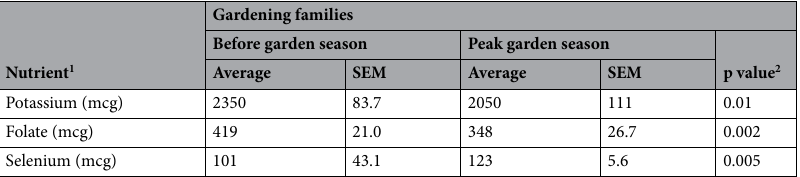
Table 4. Diet record nutrient differences within gardening families from before the garden season to peak garden season. 1 Average nutrient values ± SEM. 2 Two-sided Wilcoxon test.